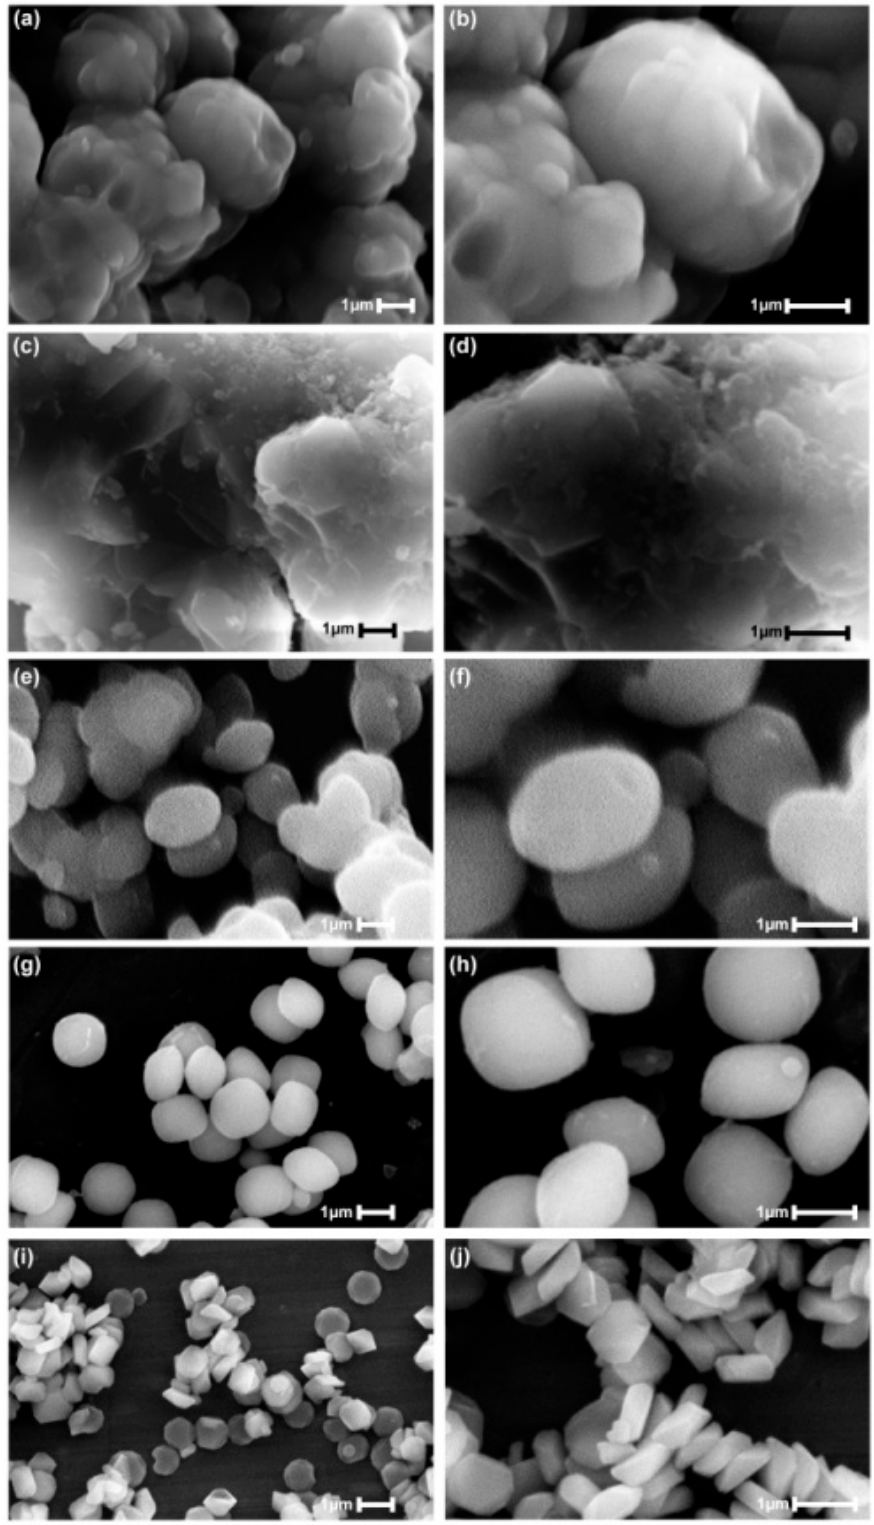
Figure 6. Scanning electron microscopy (SEM) image of potassium jarosite particles synthesized at different conditions. ( a , b ) pH 0.8; ( c , d ) pH 1.1; ( e , f ) pH 2.1 with no aging time; ( g , h ) pH 2.1 with 3 days aging time; ( i , j ) pH 2.1 with 7 days aging time. Left and right column images are with magnifications 10,000 × and 20,000 × ,